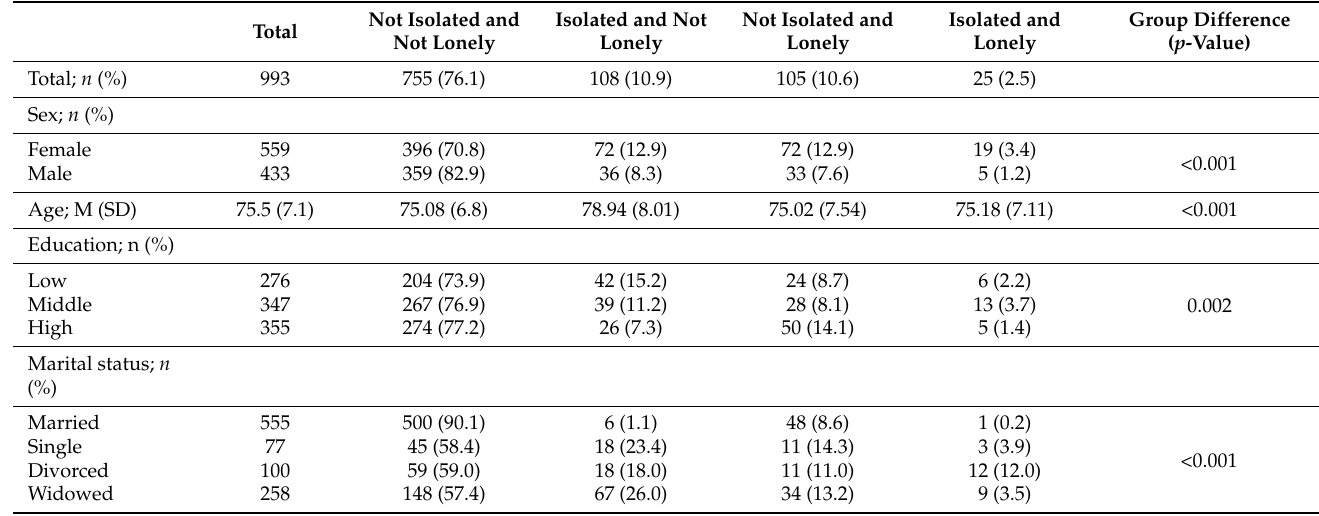
Table 1. Sociodemographic characteristics by social isolation/loneliness subgroups. Not Isolated and Isolated and Not Not Isolated and Not Lonely Lonely Lonely